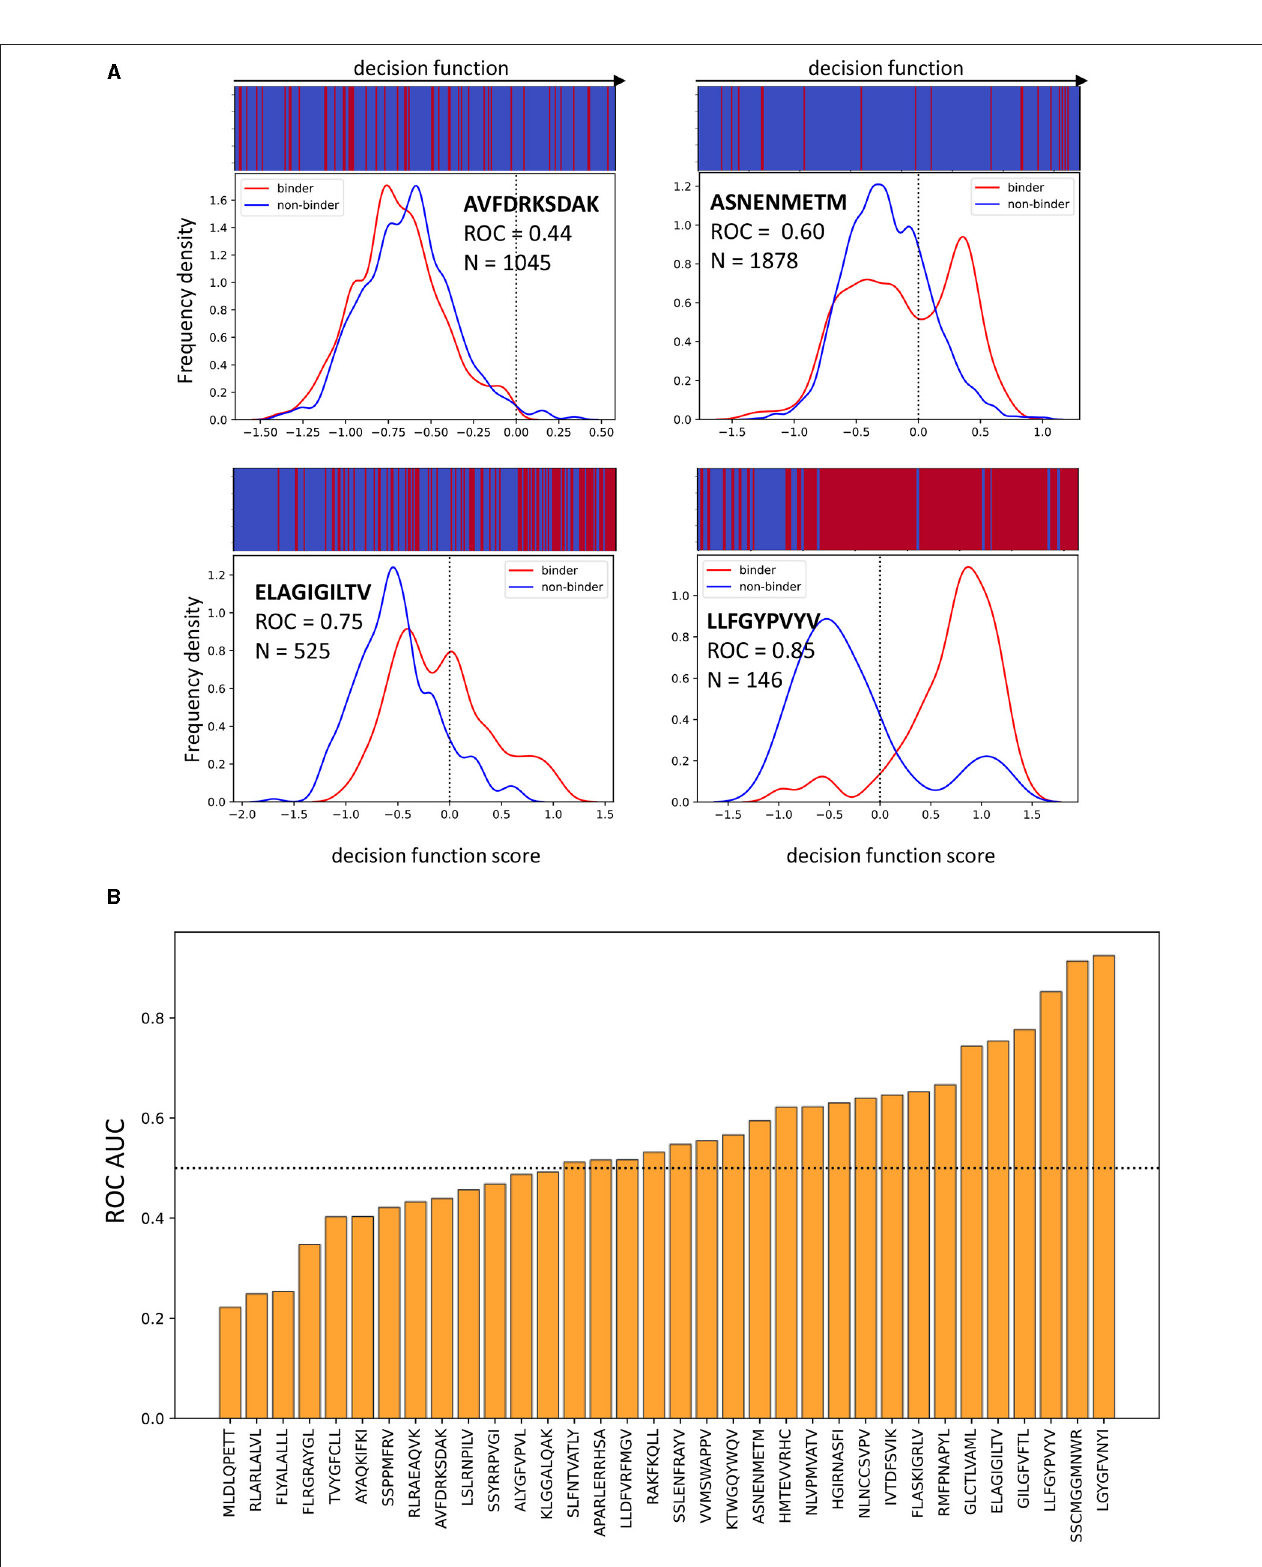
FIGURE 7 | The performance of the model is pMHC dependent. (A) Examples of four different epitopes. The frequency distributions of model decision function scores (for an SVM, this corresponds to the distance from the separating hyperplane, drawn as a dotted line) for binding and non-binding TCRs recognising each